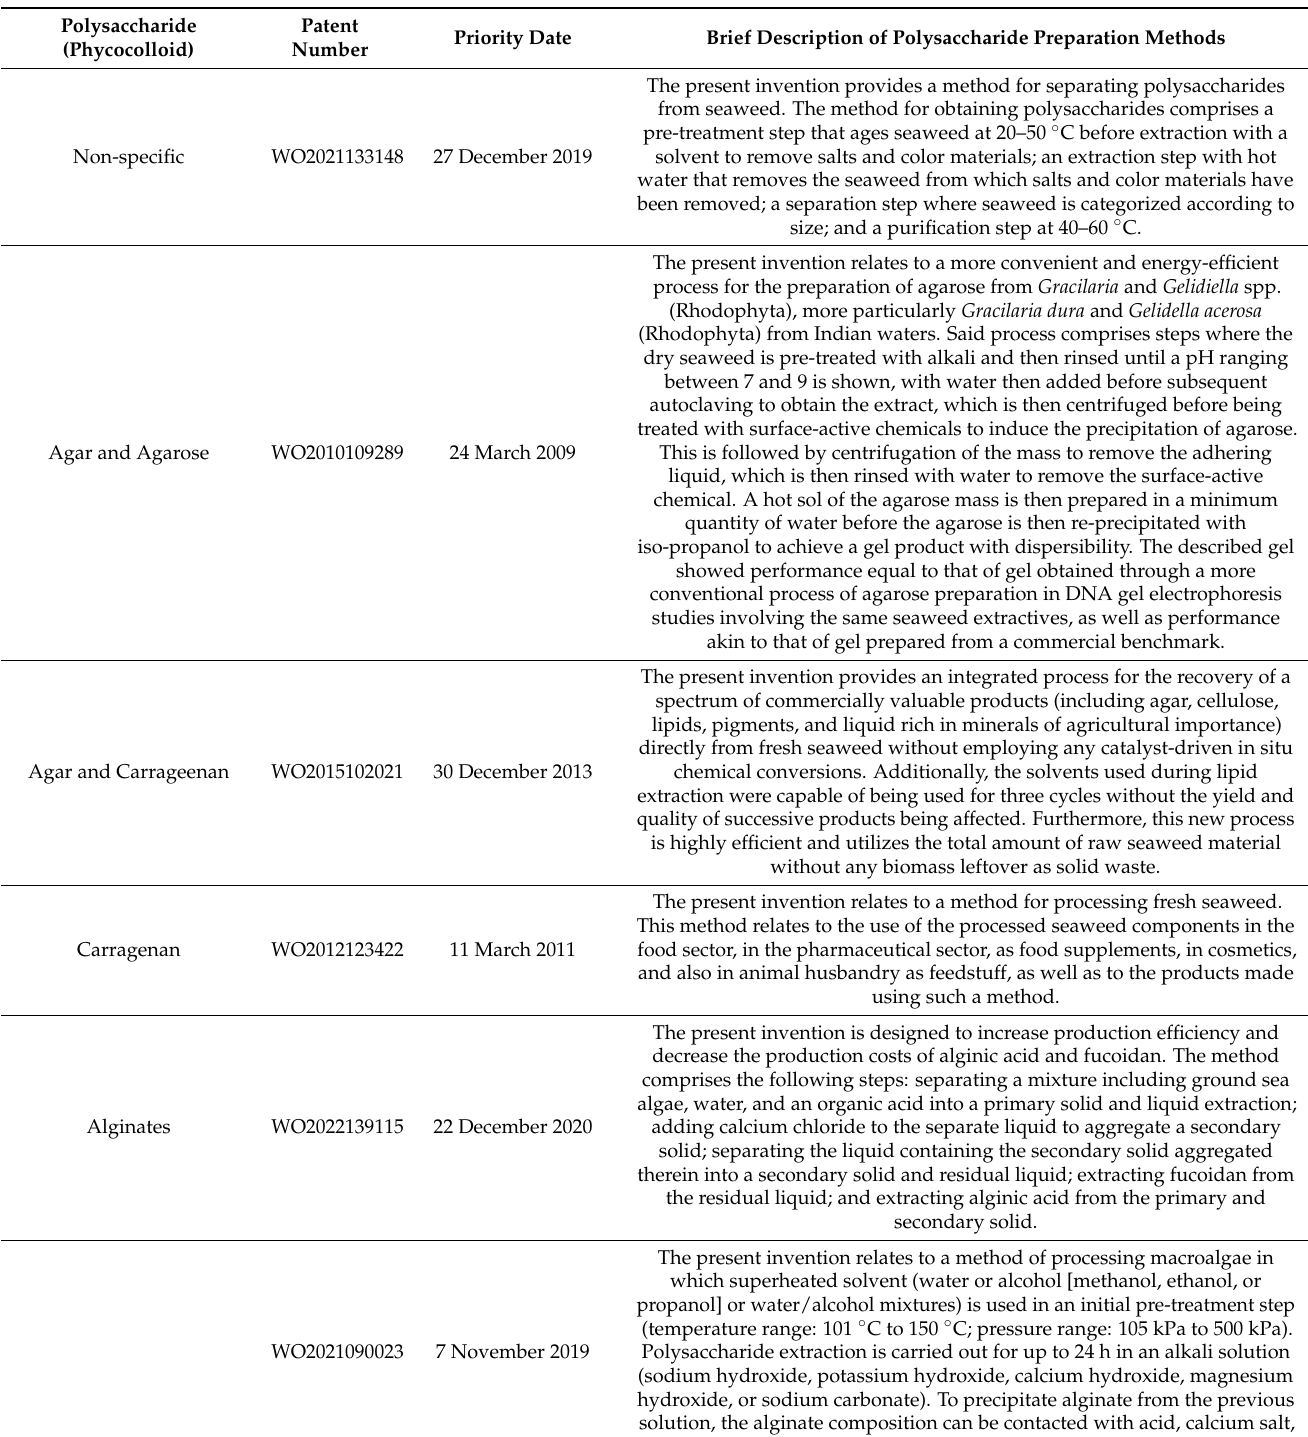
Table 3. Representative International Patent Applications regarding the preparation of polysac- charides (International Patent Classification [IPC] main group: C08B 037/00) from seaweeds (2002 to